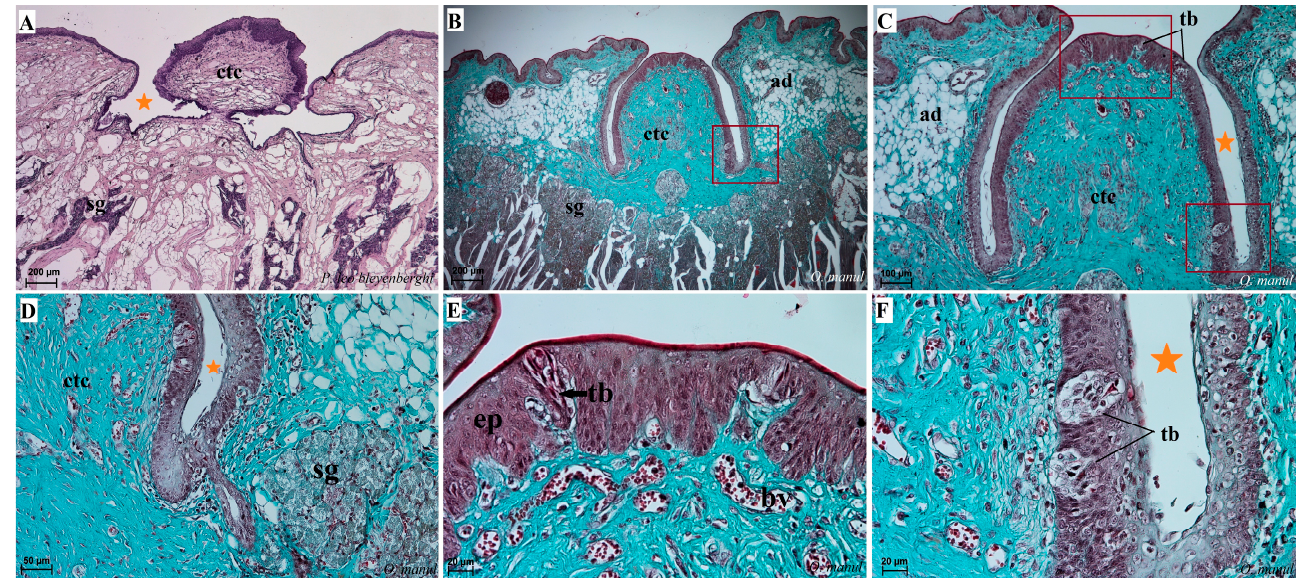
Figure 10. Histological pictures of the vallate papillae of the tongue of P. leo bleyenberghi ( A ) and O. manul ( B – F ). ( A – C ) Longitudinal section of the vallate papilla with papillary groove (orange asterisk). ( D , F ) Magnification of the lateral epithelium of the papillae with several taste